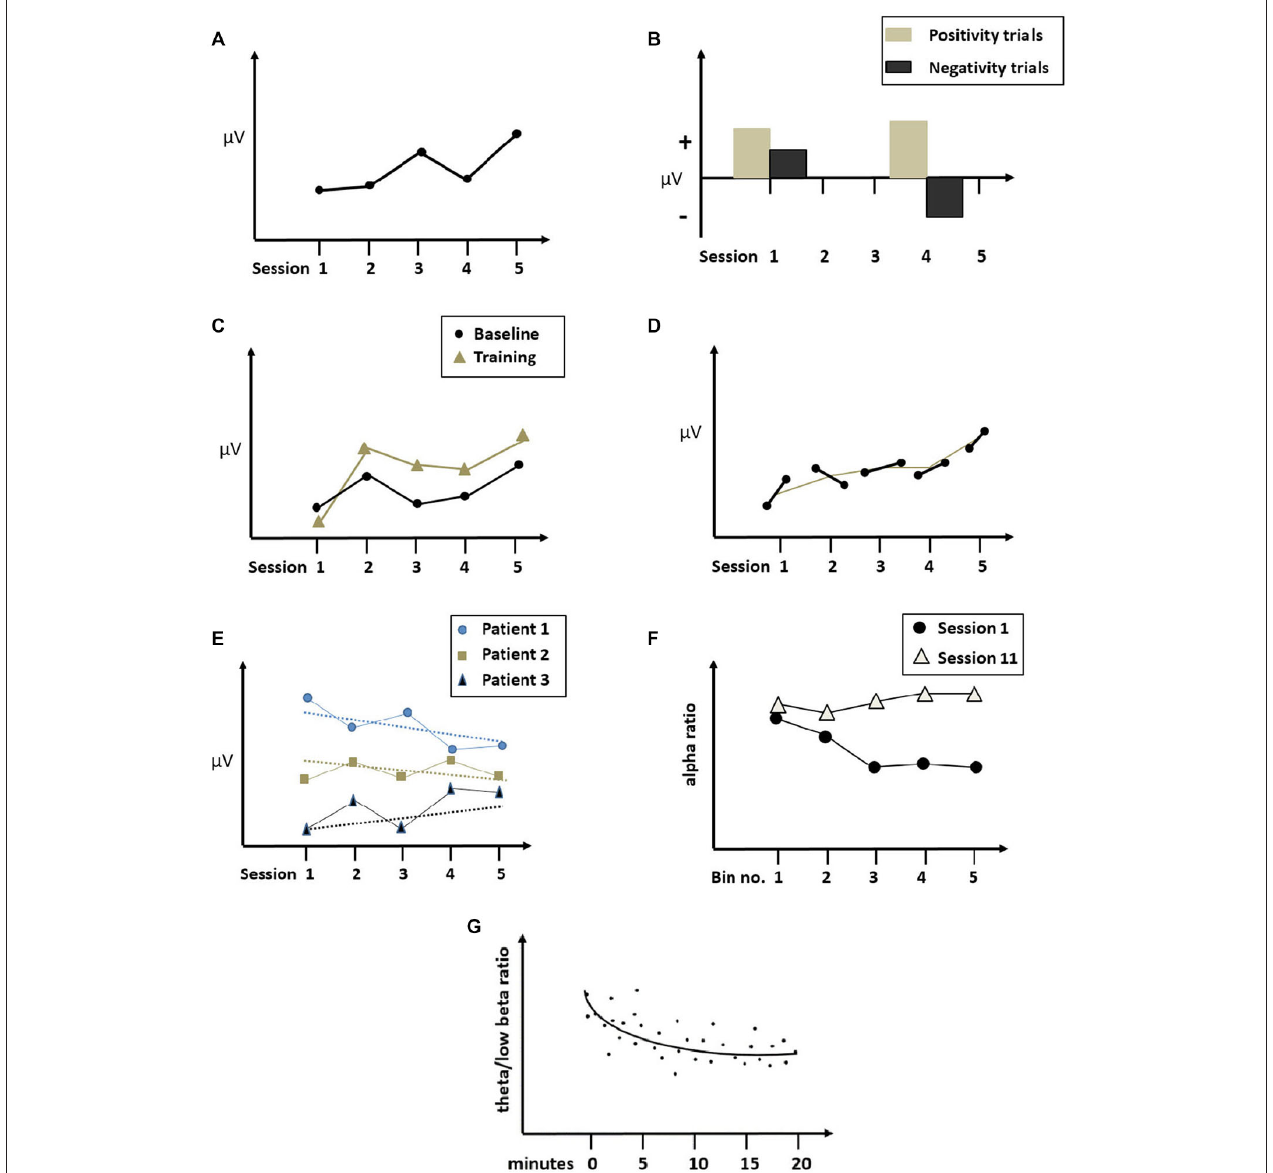
2011, modified). (E) Individual pre-session baselines across sessions (adapted from Liechti et al., 2012, modified). (F) Within session learning curves of training performance during session 1 and session 11, segmented into bins of time (adapted from Cho et al., 2008, modified). (G) Within session learning curve collapsed across sessions, indicating mean theta/beta ratio per minute (adapted from Hillard et al., 2013, modified). The figures illustrate the methods used in the studies; all data have been